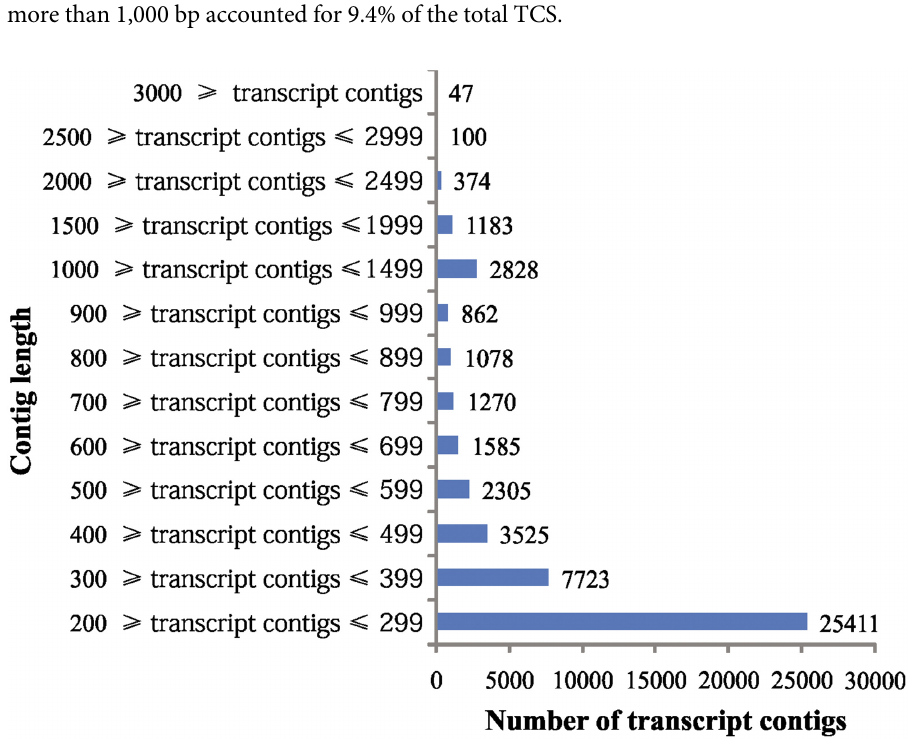
Fig 1. Distribution of transcript contig length assembled from black gram transcriptome